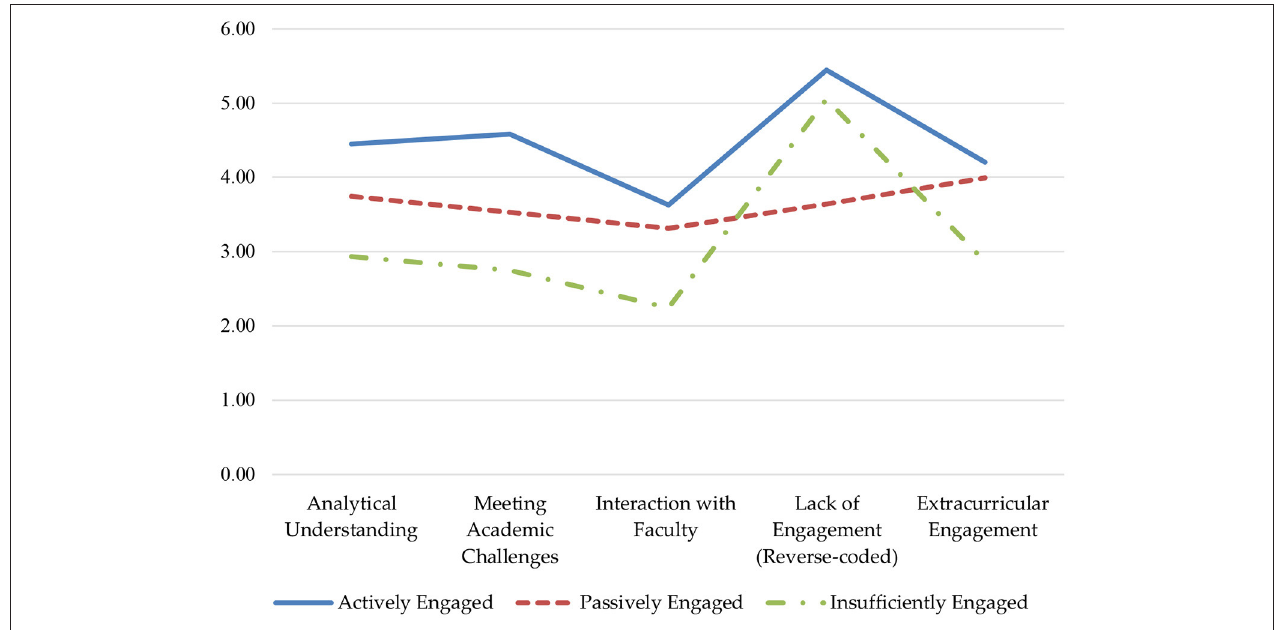
FIGURE 2 | International students’ engagement typology.